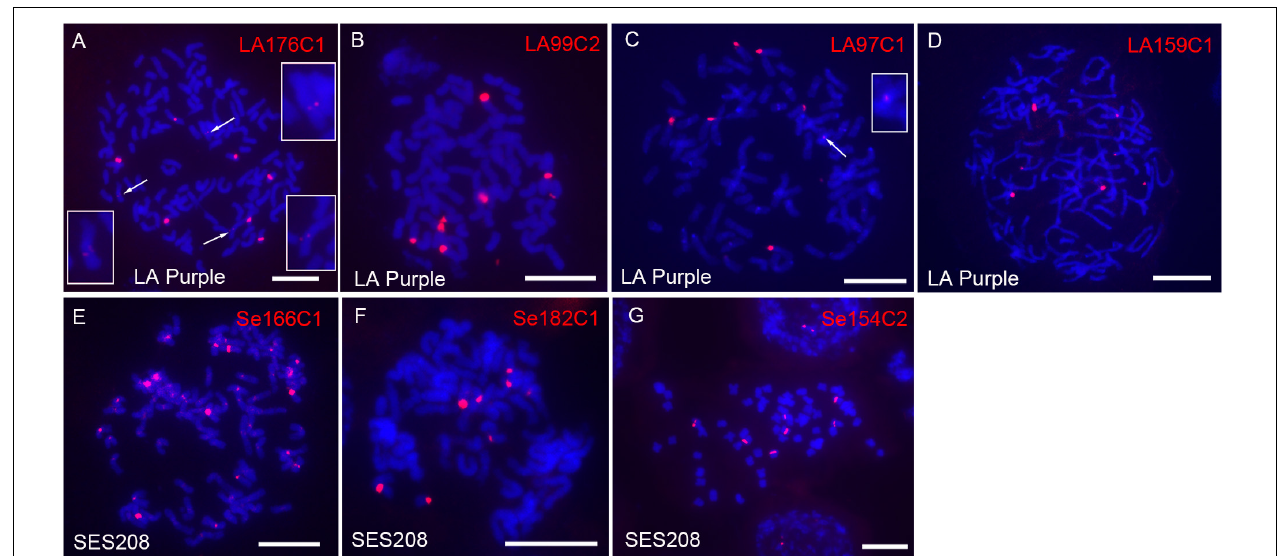
FIGURE 4 | Fluorescence in situ hybridization mapping of rDNA in LA Purple and SES208. The seven rDNA-derived repeats LA1176C1 (A) , LA99C2 (B) , LA97C1 (C) , LA159C1 (D) , Se166C1 (E) , Se182C1 (F) , and Se154C2 (G) were mapped to the metaphase chromosomes of LA Purple and SES208. The weak signals derived from probes of LA1176C1 (A) and LA97C1 (C) are indicated (arrows) and enlarged. Bars = 10 µ m.